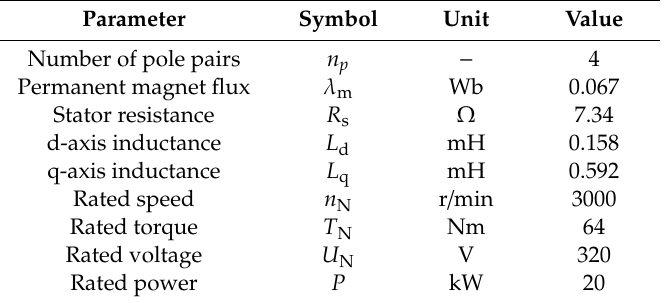
Table 1. Parameters of the